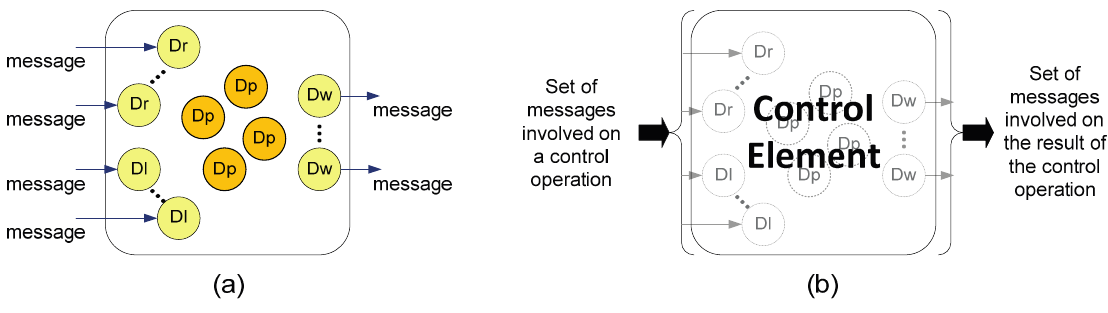
Figure 8. ( a ) Elements involved on the calculation of the internal parameters; ( b ) External parameters